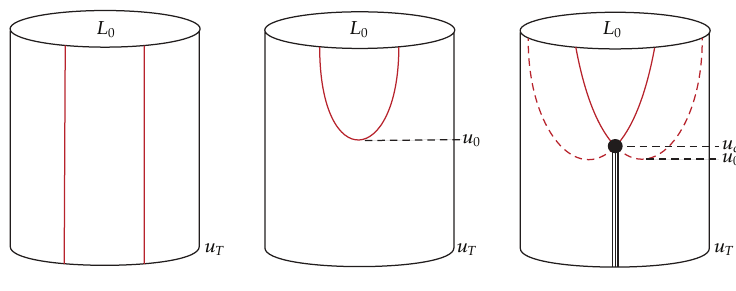
Figure 4: Configurations of χ S-QGP (cid:3) a (cid:4) vacuum (cid:3) b (cid:4) , and multiquark nuclear phase (cid:3) c (cid:4) in x 4 − u